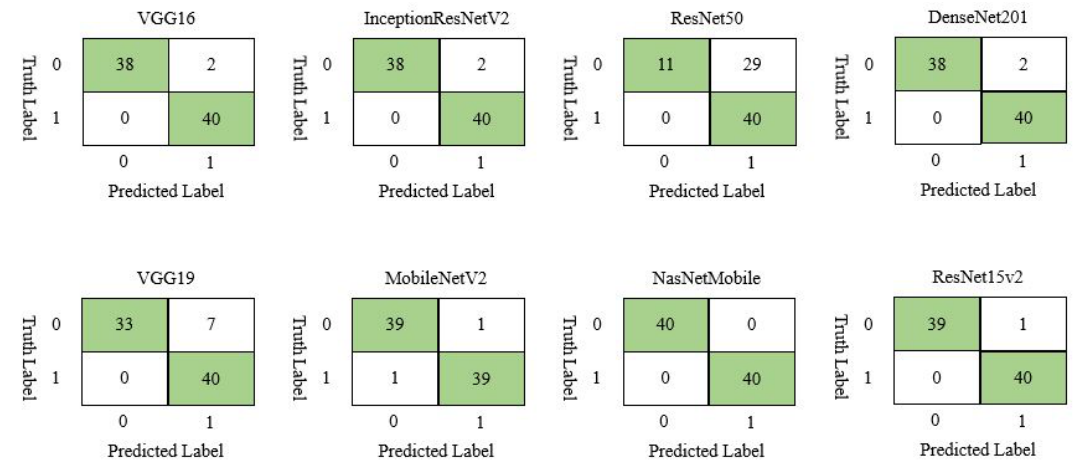
Figure 5. Confusion matrix of different deep learning model for chest X-ray image dataset.